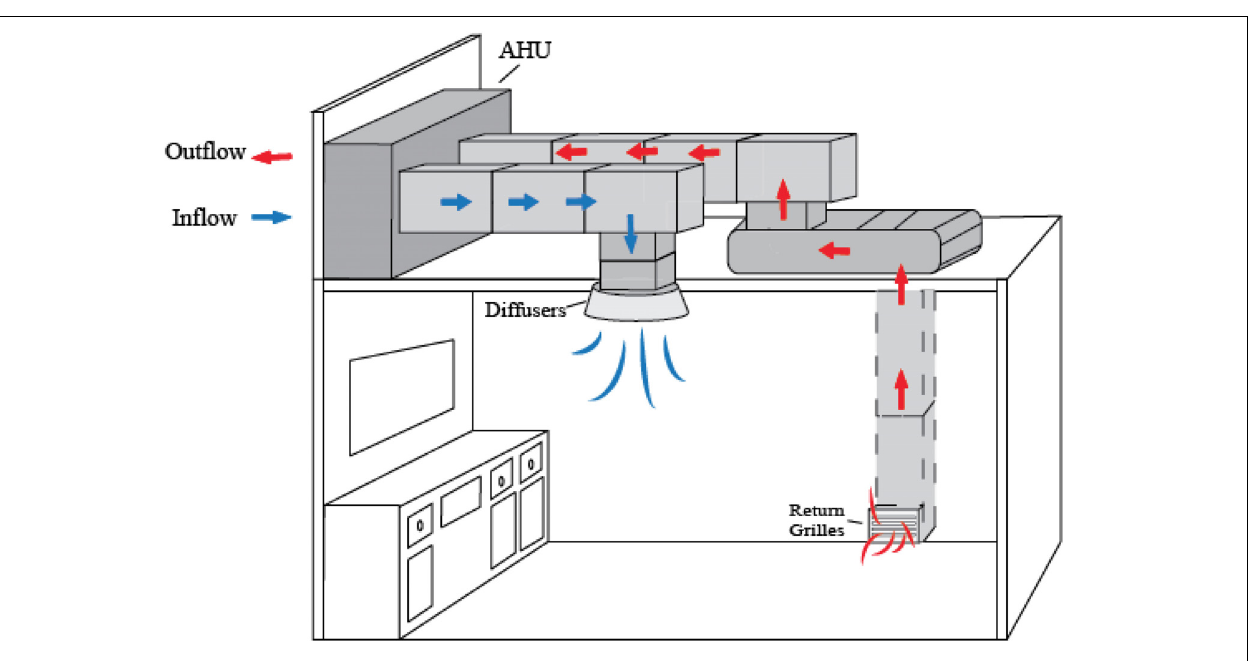
FIGURE 5 | Air circulation via HVAC systems as a means of proper ventilation of